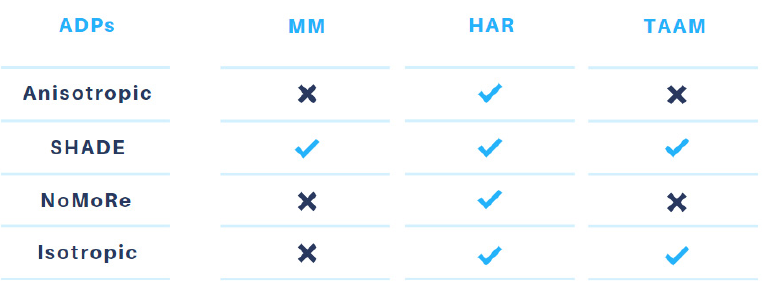
Figure 3. Summary of the modelling of H atoms in the MM, HAR, and TAAM methods.